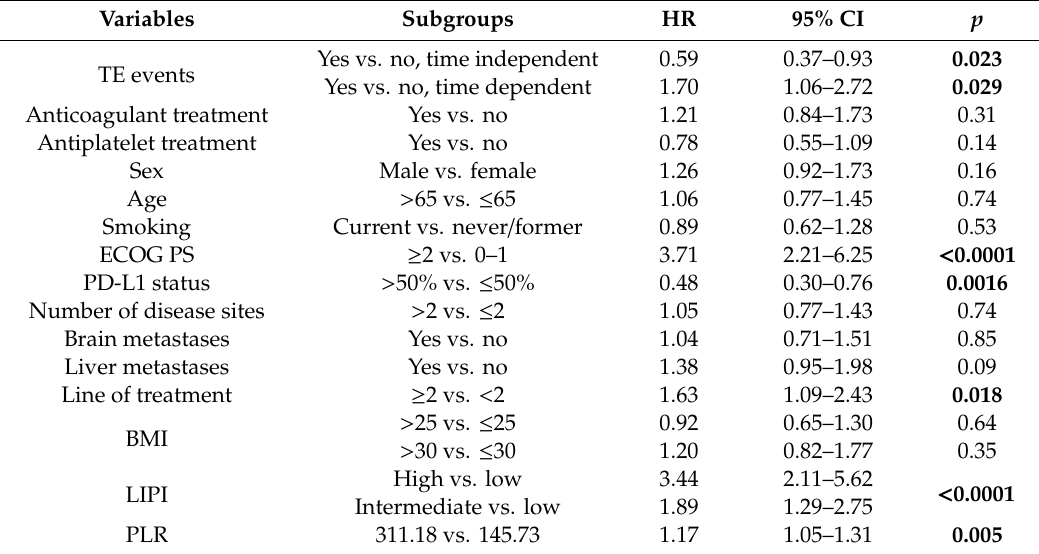
Table 5. Univariate Cox proportional hazards model for overall